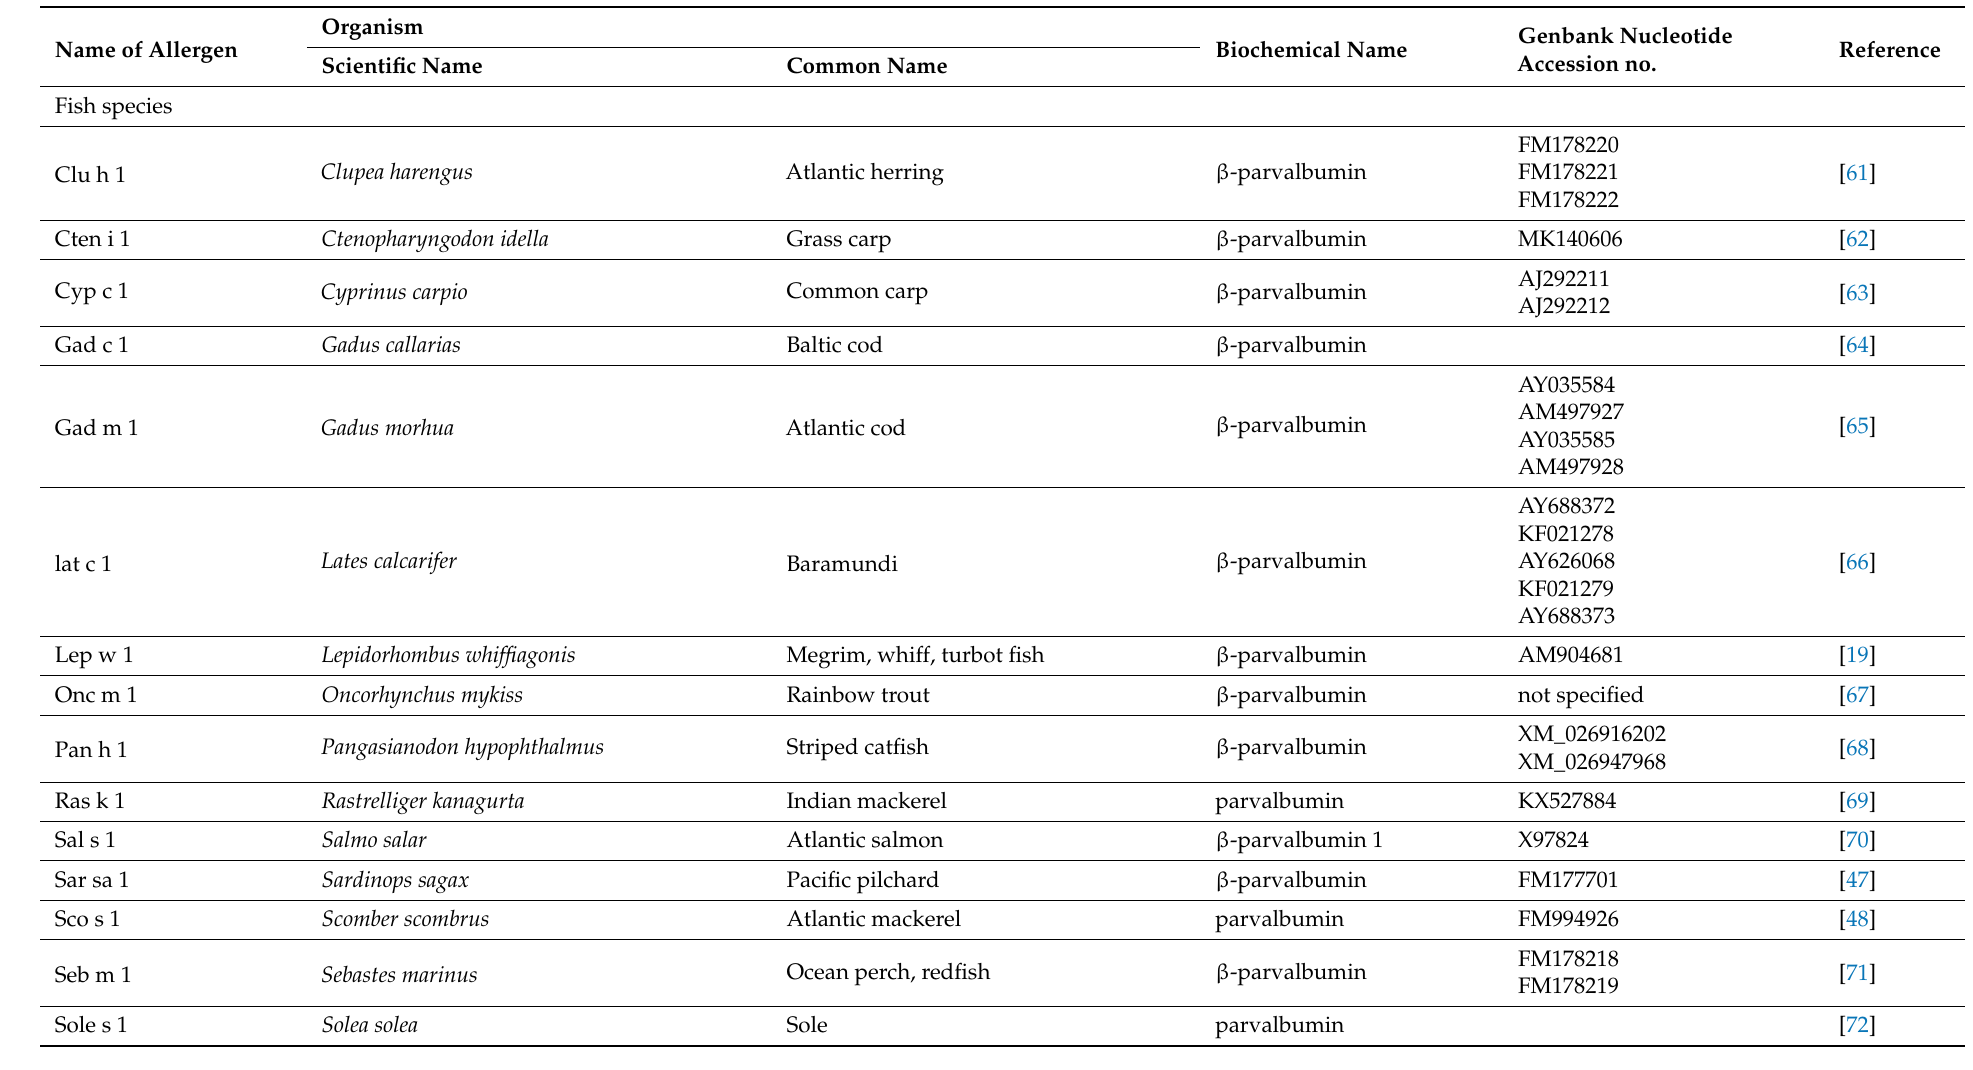
Table 1. Fish and non-fish parvalbumin allergens registered with the WHO (www.allergen.org (accessed on 15 November